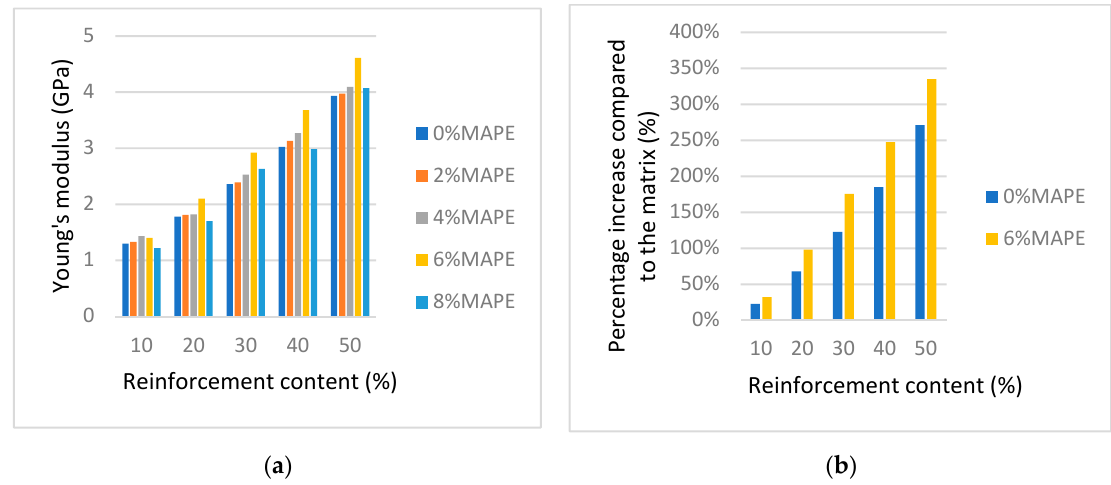
Figure 2. ( a ) Young’s moduli of the composites versus fiber content and ( b ) percentage of Young’s moduli increase in front of the matrix value.